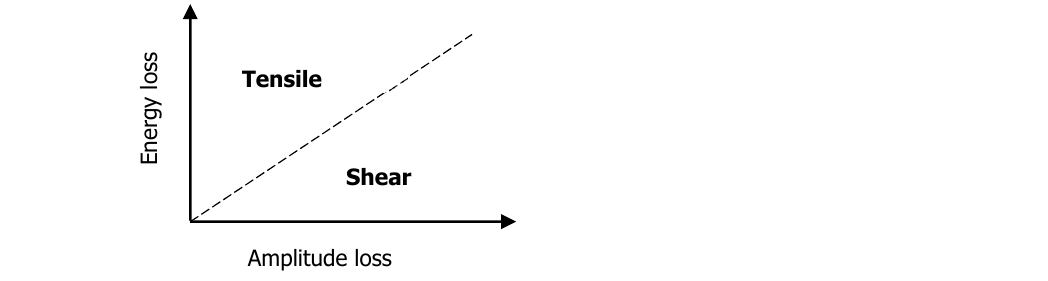
Figure 15. An inference based on the 3D-PCT results is the relationship between amplitude and energy losses with the damage type.